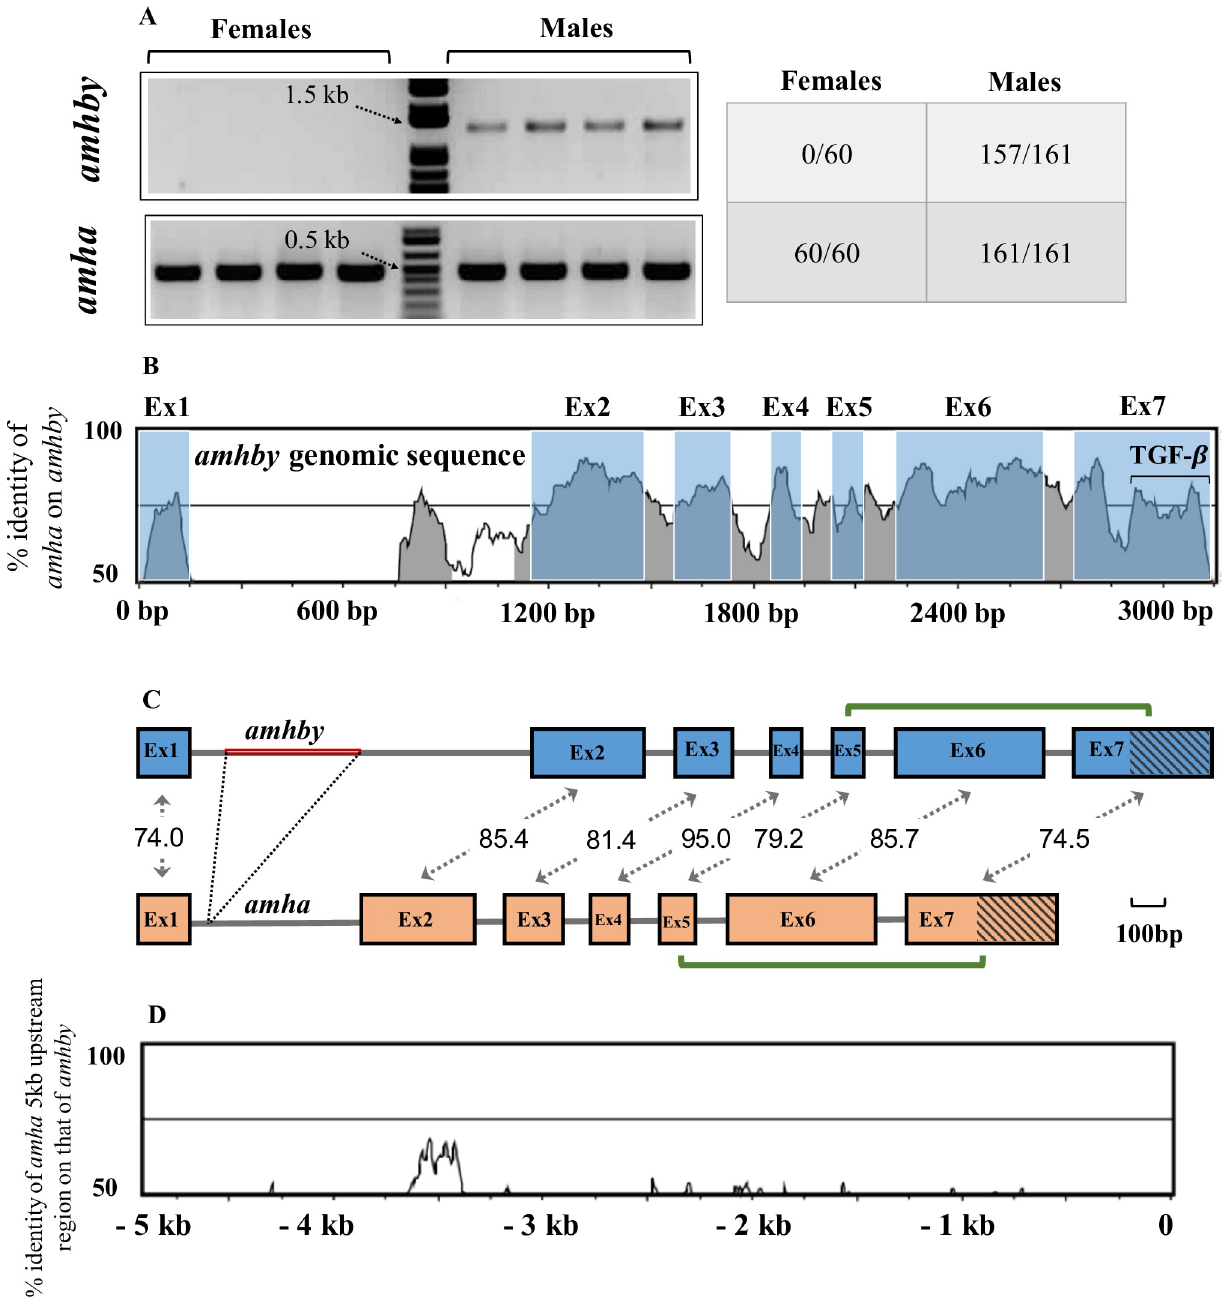
Fig 1. Sequence identity between amha and amhby and amplification in males and females. A) PCR amplification of amha (500 bp band) and amhby (1500 bp band) in male (n = 4) and female (n = 4) genomic DNA samples from E . lucius . Each lane corresponds to one individual. The number of tested animals of each sex positive for amha and amhby is indicated in the table on the right. B) Sequence identity of global pairwise alignment between amha and amhby genomic sequences with the amhby sequence as reference. C) Schematic representation of amha and amhby gene structure in E . lucius from the start to the stop codon. Exon1-Exon7 are represented by green boxes with shared percentage identity indicated and introns are represented by white segments. The red segment in intron 1 represents the amhby specific insertion. TGF- β domains are indicated with diagonal lines. D) Global pairwise alignment between 5 kb upstream region of amha and amhby with amhby as the reference. The start codon of each gene is positioned at 0 bp and the number on the y-axis indicates distance from the start codon upstream to the coding sequence.